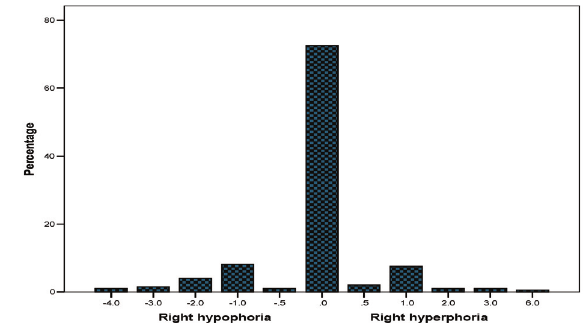
Figure 4 Distribution of vertical heterophoria for near vision (total sample). A large proportion of the values are orthophoria and the peak is also at orthophoria.